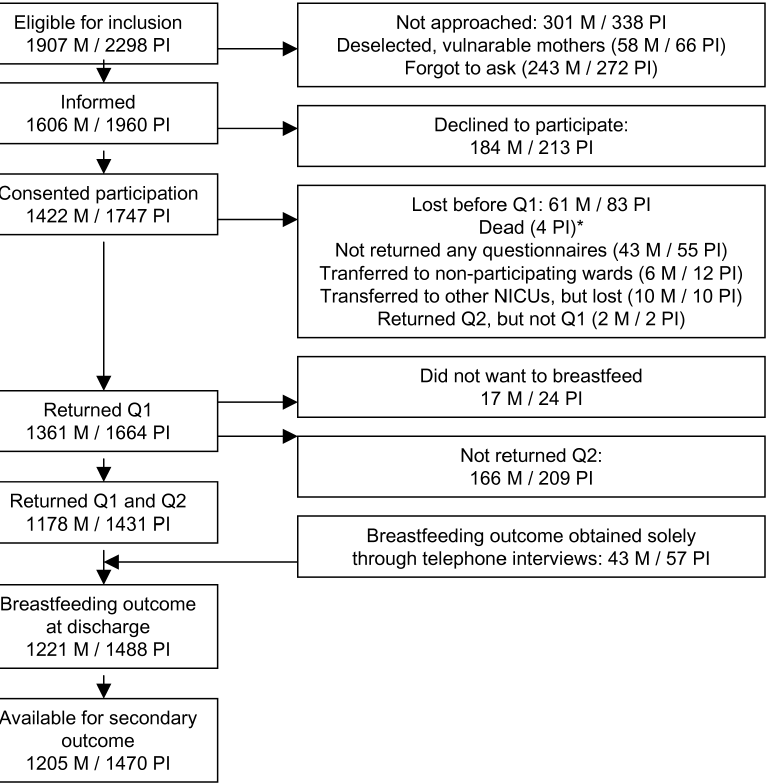
Figure 1. Flow chart. BF = breastfeeding, M = mothers, NICU = Neonatal Intensive Care Unit, PI = preterm infants, Q1 = Questionnaire 1, Q2 = Questionnaire 2. *The four infants who died after inclusion were all twins, no mothers were lost due to infant death.